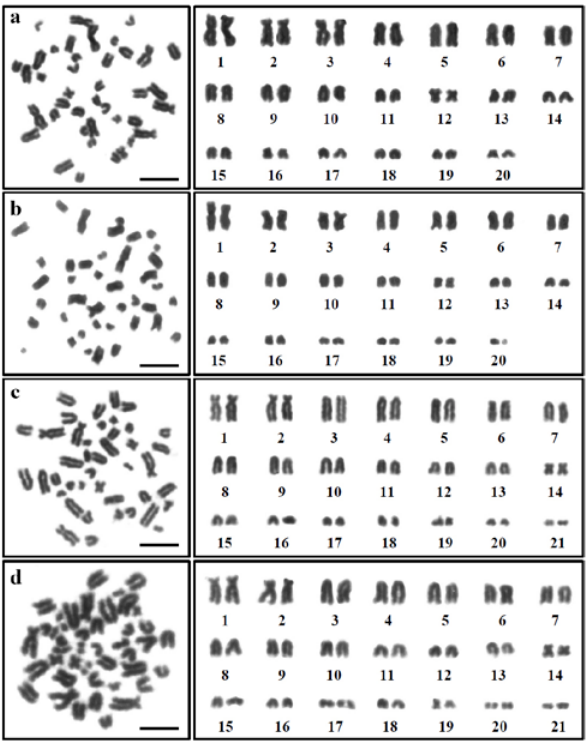
Abbreviations: Ch.p , chromosome pair; Ch.s , chromosome size; Ch.t , chromosome type; * , nucleolar organizer region; L , large size; M , medium size; S , small size; m , metacentric; sm , submetacentric; t ,